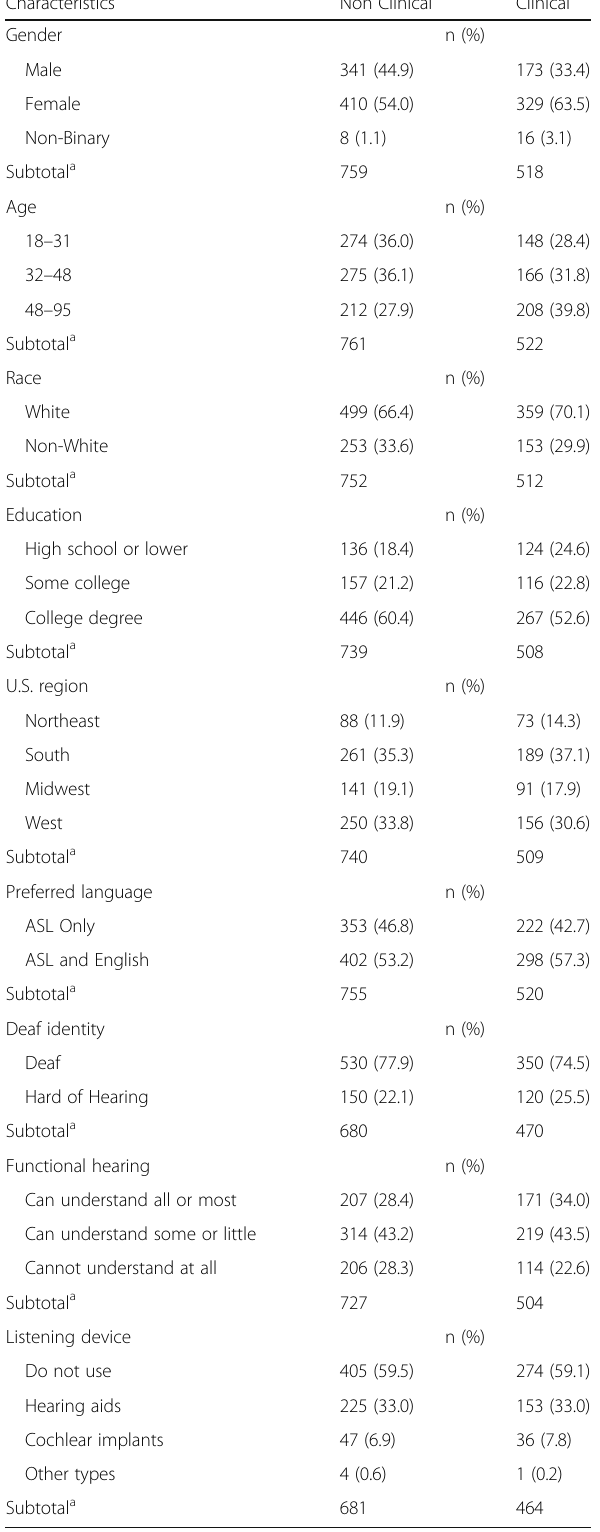
Table 1 Unweighted Sample Characteristics by Clinical Status